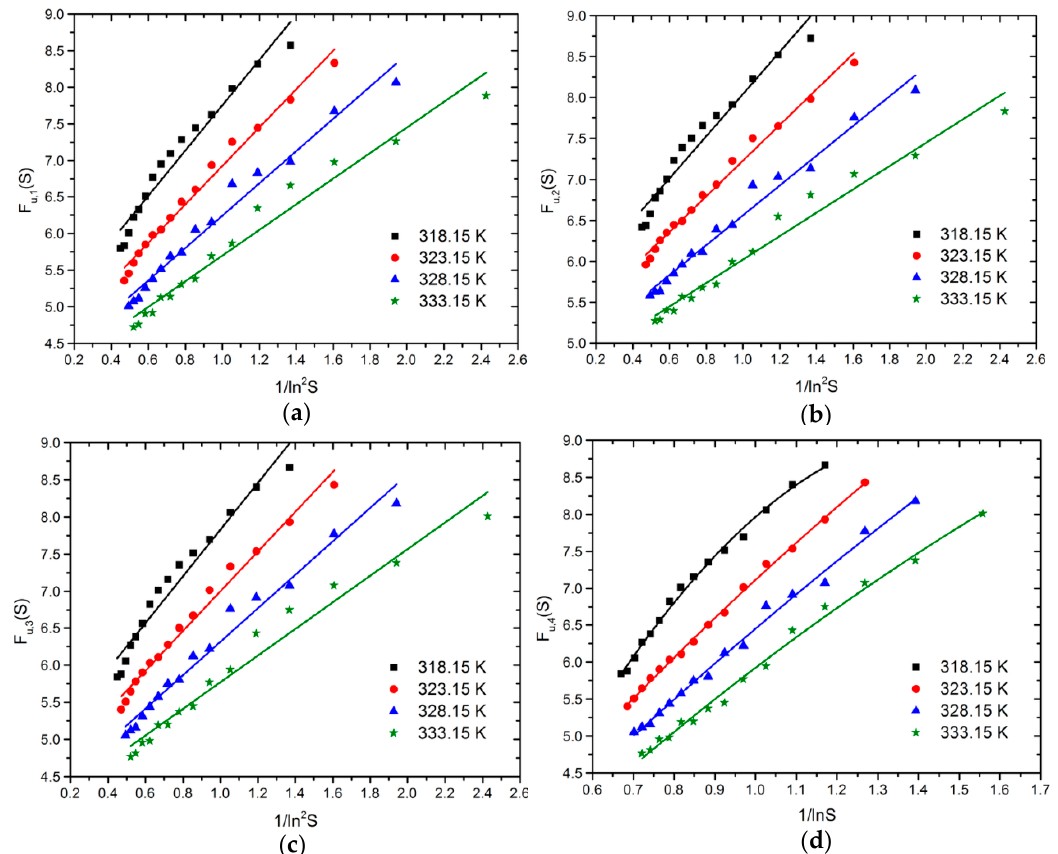
Figure 5. Plot of 𝐹 (cid:3048) (S) versus 1/lnS or 1/ 𝑙𝑛 (cid:2870) 𝑆 for Li 2 CO 3 crystals. Data are fitted using ( a ) normal Figure5. Plotof F u ( S ) versus1/lnSor1 / ln 2 S forLi 2 CO 3 crystals. Dataarefittedusing( a )normalgrowth, growth, ( b ) spiral growth, ( c ) volume diffusion-controlled growth, and ( d ) 2D nucleation-mediated ( b ) spiral growth, ( c ) volume di ff usion-controlled growth, and ( d ) 2D nucleation-mediated growth. Table 4. The coefficients of determination R 2 for different growth mechanisms of Li 2 CO 3 under different temperatures.